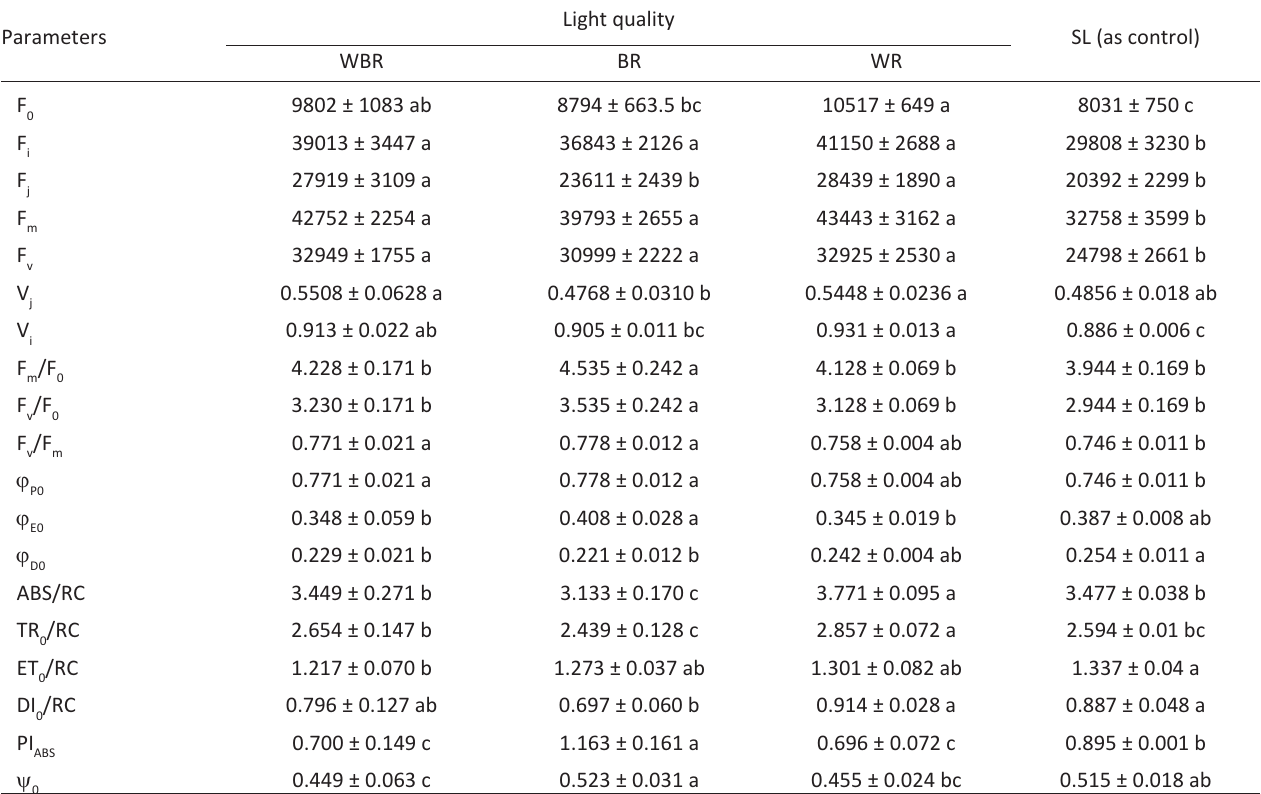
Table 4 ­ Chlorophyll fluorescence of transplants grown under white+blue+red (WBR), blue+red (BR), white+red (WR) and sunlight rep­ resented by means values ± standard deviation (n=5) Light p≤0.05).Parameters Values followed by the same letter within a row do not significantly differ (by the tukey’s test,